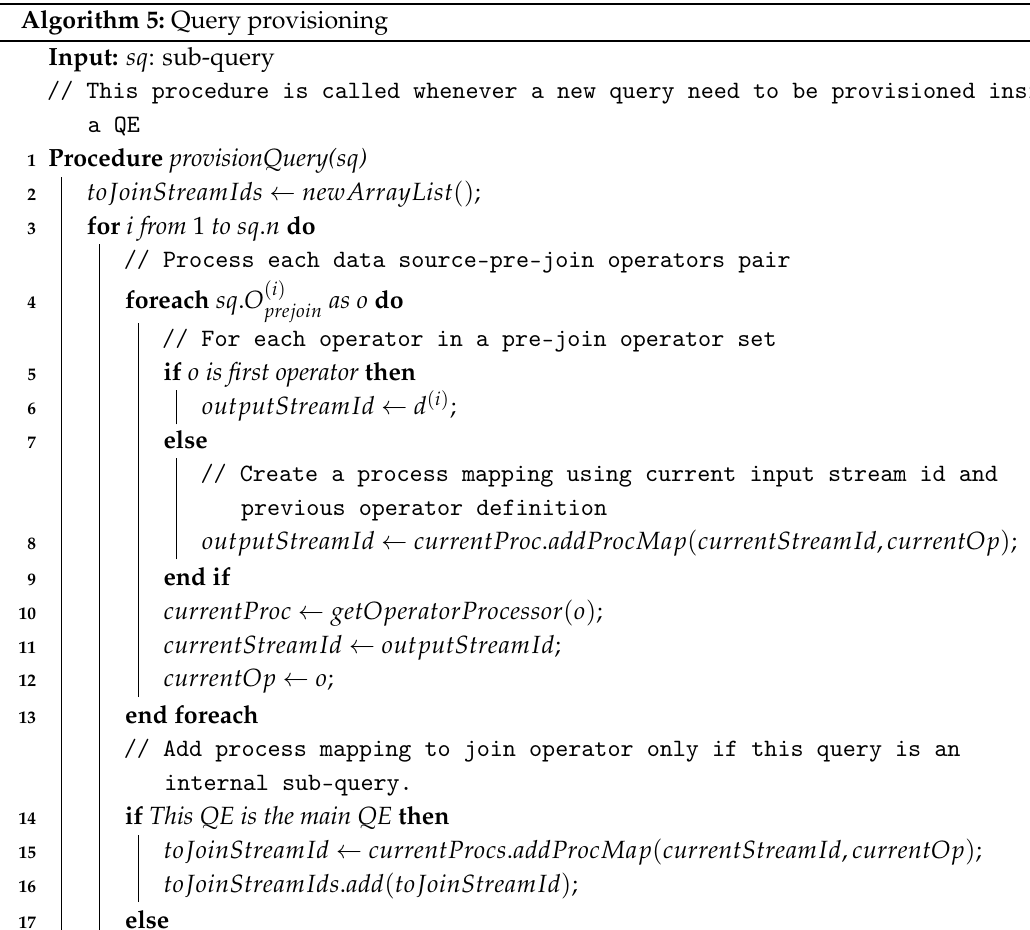
Algorithm 5: Query